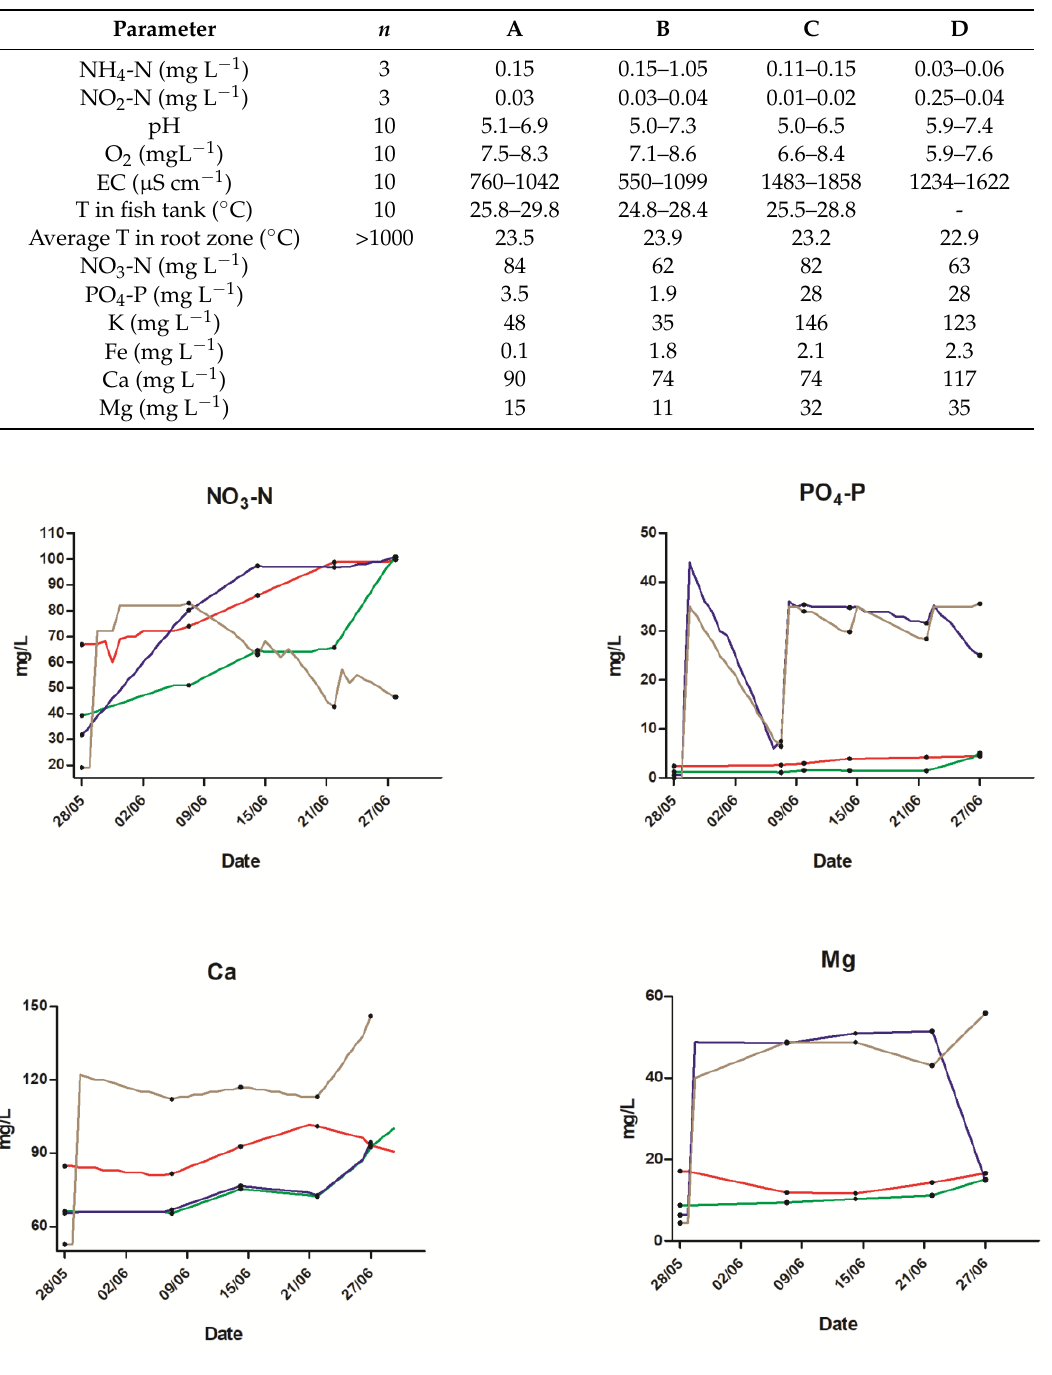
Table 1. Recorded water quality and calculated average nutrient concentration in each system.